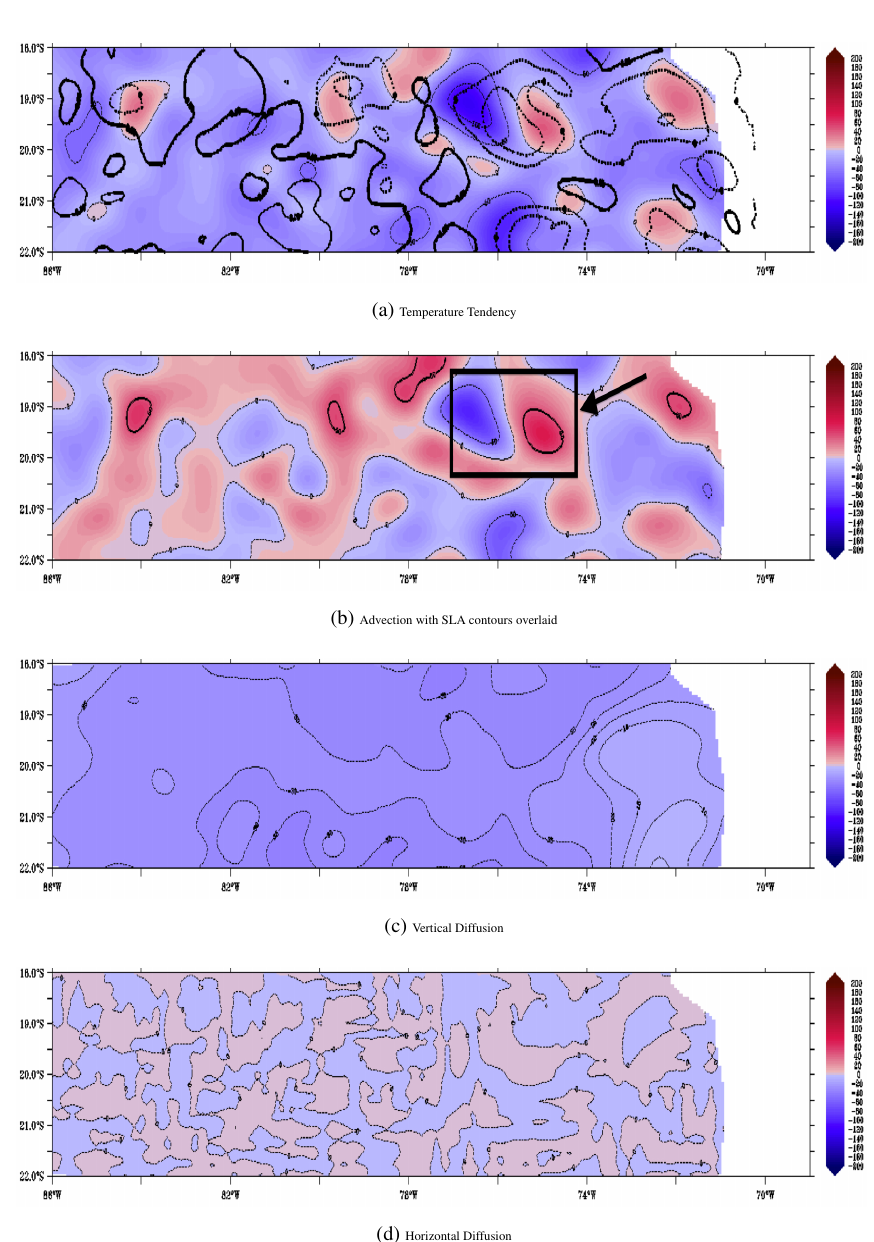
Fig. 15: Spatial maps of heat budget (W m − 2 ) terms from the model for 86 ◦ W–69 ◦ W and 22 ◦ S–18 ◦ S. The heat budget terms are integrated to the depth of 400 m and for a period of two weeks when the eddy was strongest. The eddy region is highlighted by a black box around in Fig. b and by the SLA contour overlaid in Fig. a